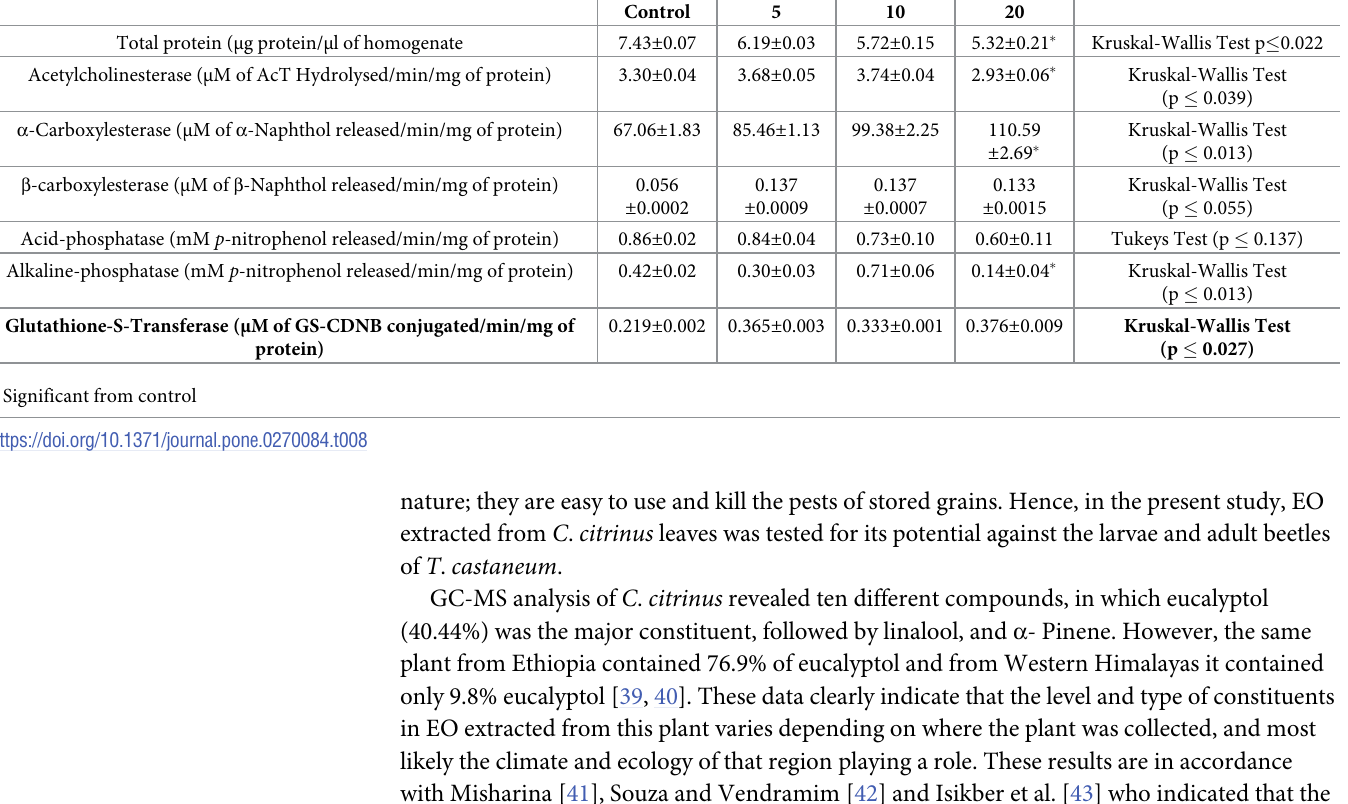
Table 8. Biochemical effect of essential oil of C . citrinus on T . castaneum . BIOCHEMICAL STUDIES